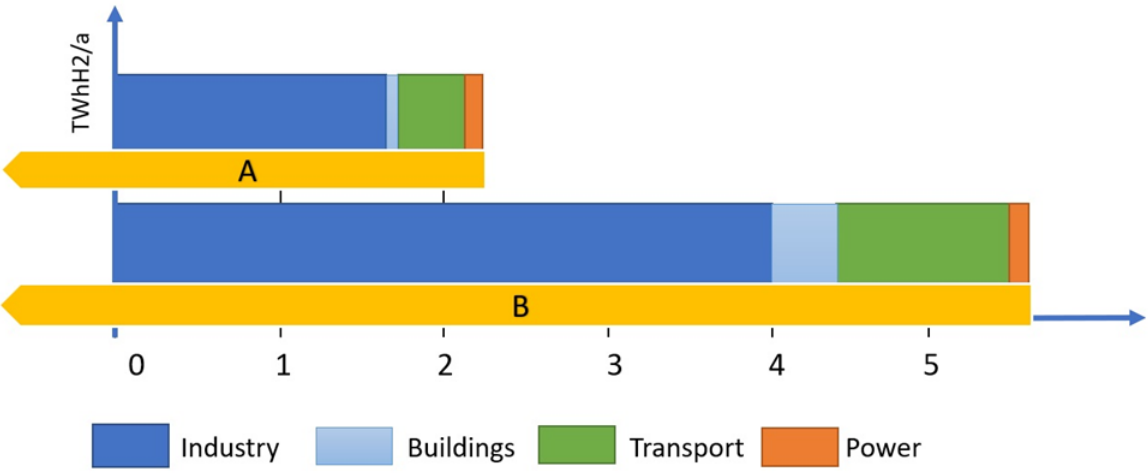
Figure 4. Scenario with low and high range of uncertainty [56].